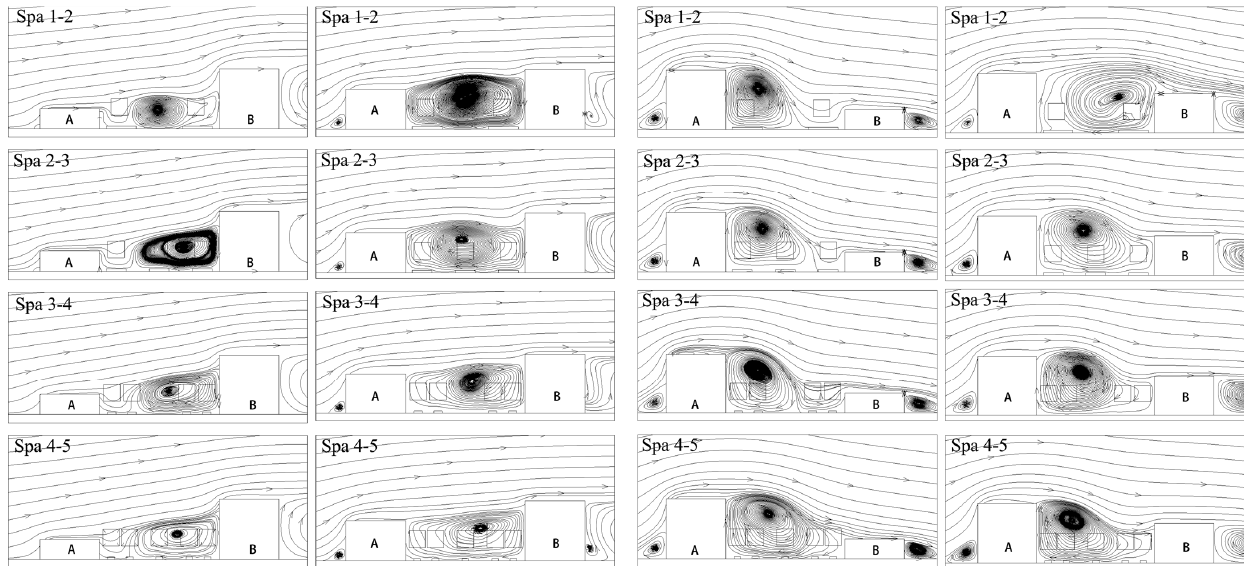
Figure 15. Plane streamline diagram at Z/H = 0 with different road green-belt scenarios. When ASF = 3/1 in the step-down street canyon, the bypass flow at the roof of Building A is blocked by the trees on the windward side and then slopes and sinks in the middle, to flow into the windward and the leeward side, respectively. The leeward wall uplifts the airflow moving into the leeward side. It meets the strong airflow on the roof of building A and turns downward to form a vortex on the leeward side. The airflow carried by the angular vortex is blocked by the green belt on the leeward side. It then sinks into the street canyon, increasing the airflow velocity on the leeward side to create the maximum velocity. This high area is most evident in the form of Spa1-2. With the increase in the green belt, the airflow carried by the angular vortex into the middle of the street canyon gradually decreases, and a maximum velocity reduction area is formed in the middle of the street canyon and near the two ends, which continues to the windward side.